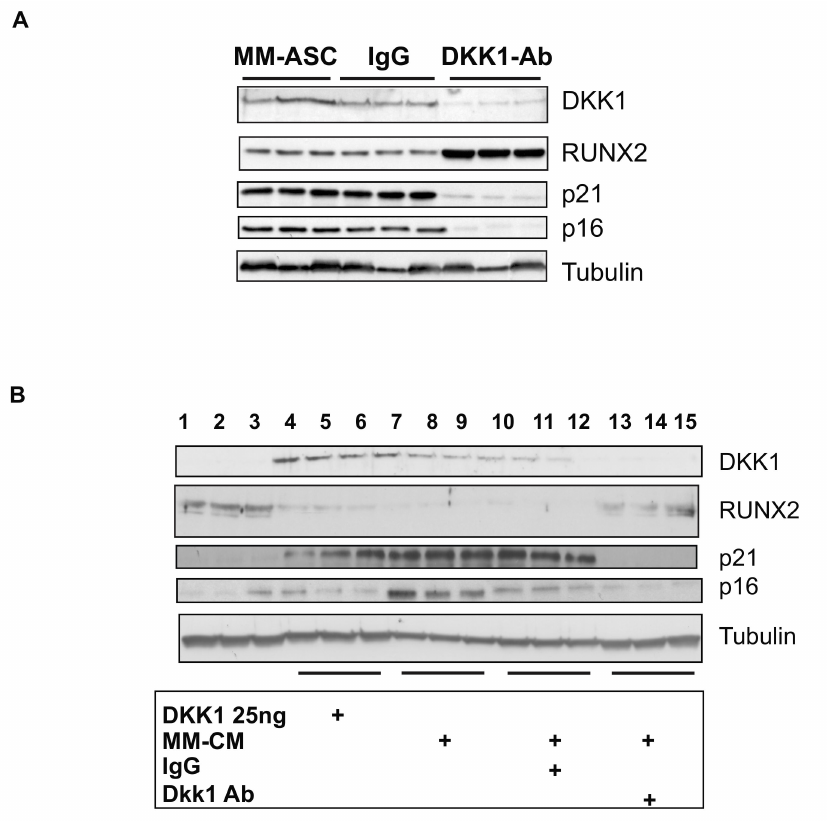
Figure 6. DKK1 inhibition rescues RUNX2 expression. ( A ) MM-ASC were cultured without or with an anti-DKK1 monoclonal antibody (DKK1-Ab) or IgG as control. Whole cell lysates were extracted and analyzed by immunoblotting. Representative immunoblots of RUNX2, DKK1, p16, p21, and tubulin (loading control) are shown. ( B ) The reverse experiment was performed by adding either recombinant DKK1 protein or conditioned medium (CM) from MM-ASC cultures to HD-ASC cultures, incubated or not with anti-DKK1. Immunoblots are